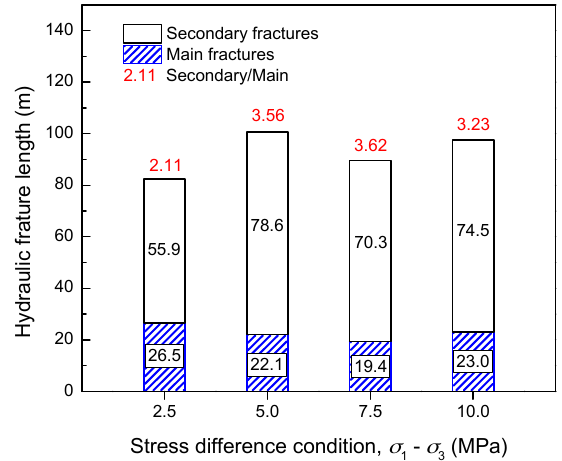
Figure 11. The hydraulic fracture lengths under different stress conditions.